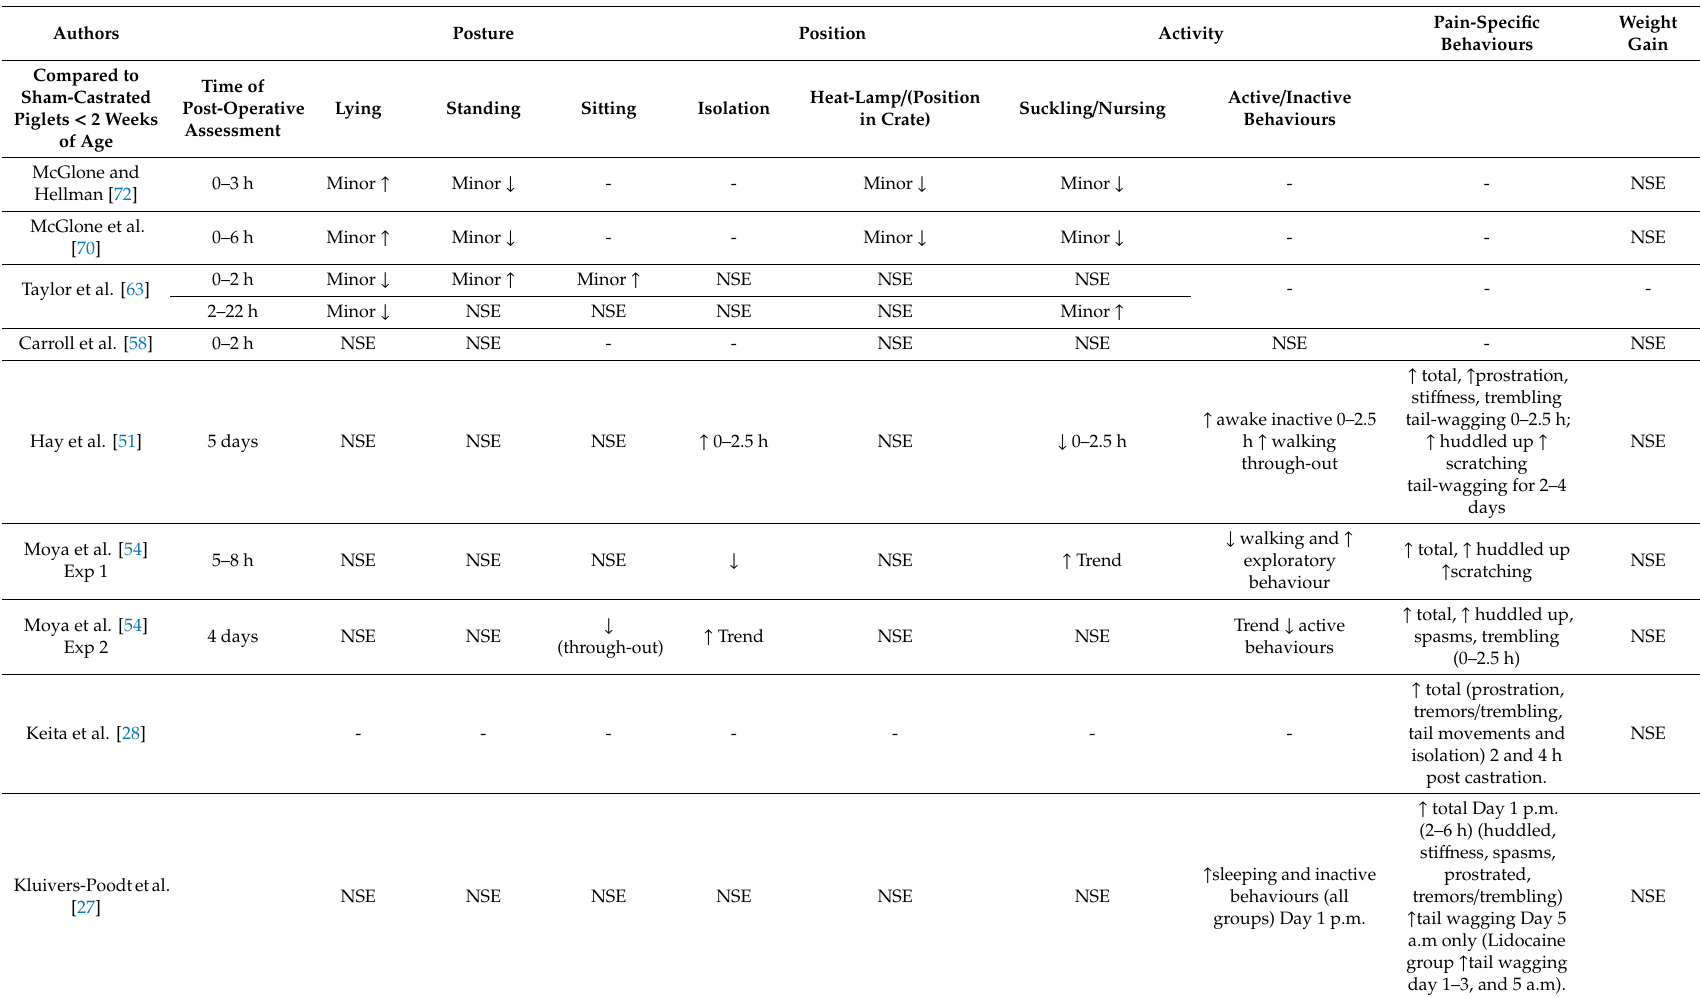
Table 5. Summary of statistically significant results ( p < 0.05) from behavioral studies examining posture, position, activity and pain-related behaviours in neonatal piglets post-castration as compared with sham-handled piglets. (Arrows indicate statistical significance. NSE = No significant e ff ect of